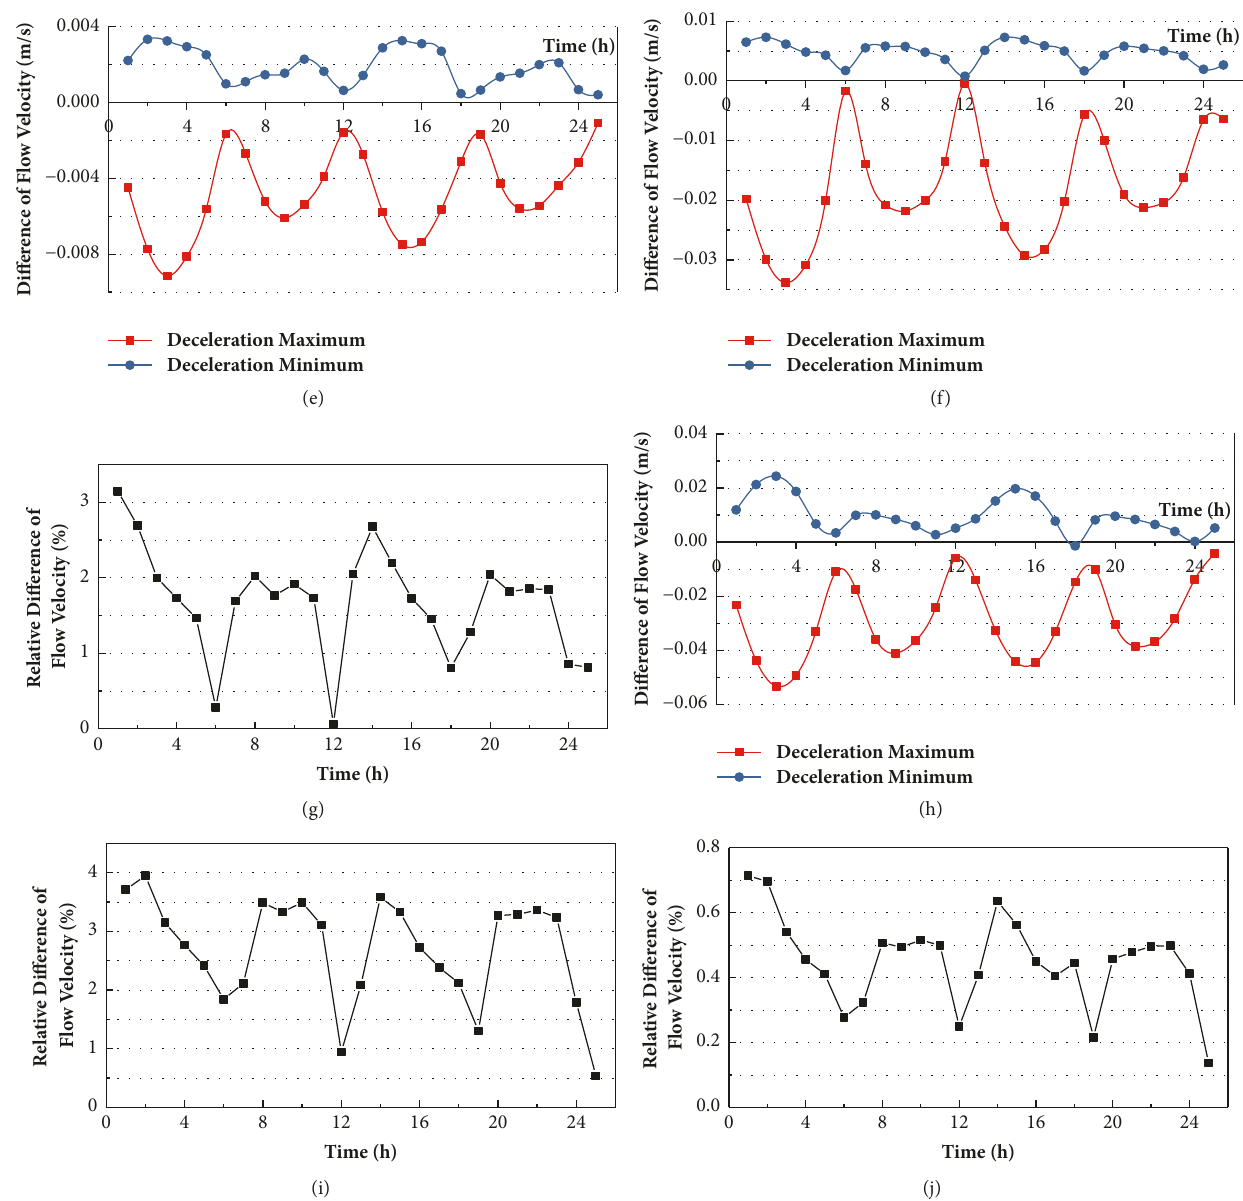
Figure 16: Variations in flow velocity of circumference with radius of 300 m: (a) and (b) represent B1 location; (c) and (d) represent B2 location; (e) and (f) represent B3 location; (g) and (h) represent B4 location; and (i) and (j) represent B5